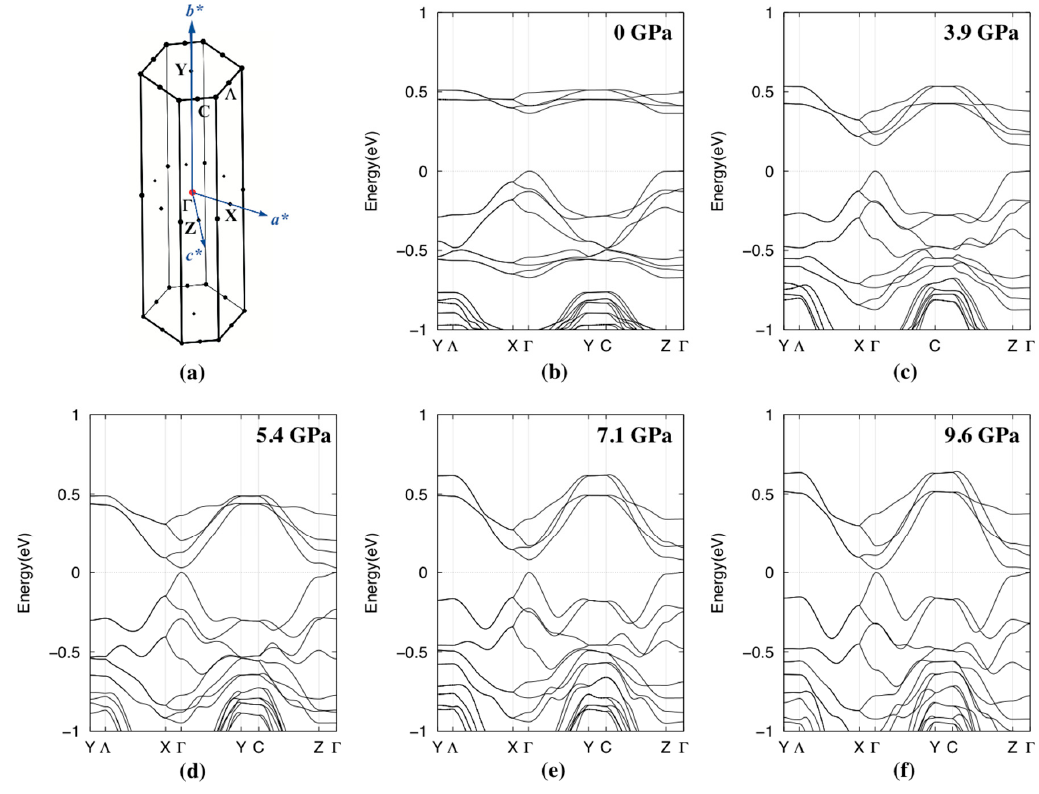
Figure 5. High pressure electronic band structures calculated with the GGA-PBE functional, based on the experimentally-determined structures of [Ni(dddt) 2 ]: ( a ) Brillouin zone and the reciprocal lattice vectors of the structure in P 2 1 / a , ( b ) ambient pressure, ( c ) 3.9 GPa, ( d ) 5.4 GPa, ( e ) 7.1 GPa, and ( f ) 9.6 GPa. The dotted line at Energy = 0 eV represents the top of the valence bands.